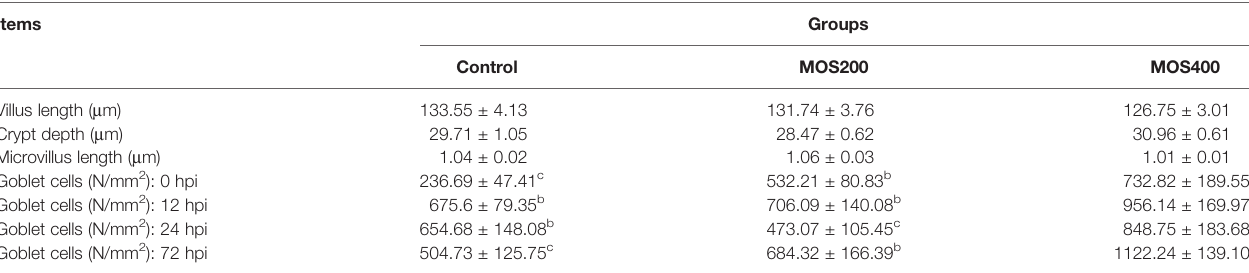
TABLE 3 | Statistical analysis of juvenile M. amblycephala intestinal histology fed with or without MOS (mean ± SE).